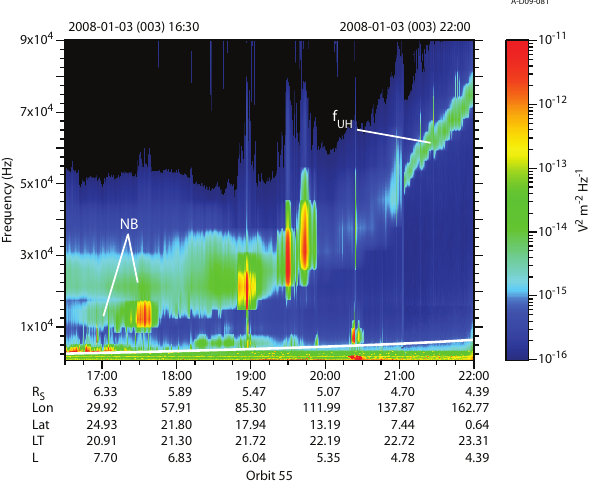
Fig. 1. A frequency versus time wave spectrogram for day 003 of 2008 for the time interval 16:30 to 22:00UT. The frequency axis is linear ranging from 1 to 90kHz. The white line near the bottom of the plot indicates f ce , and upper hybrid resonance emission is in- dicated with an arrow. Narrowband emission, indicated by arrows, emanates from possible source regions near 17:30 and 19:00.